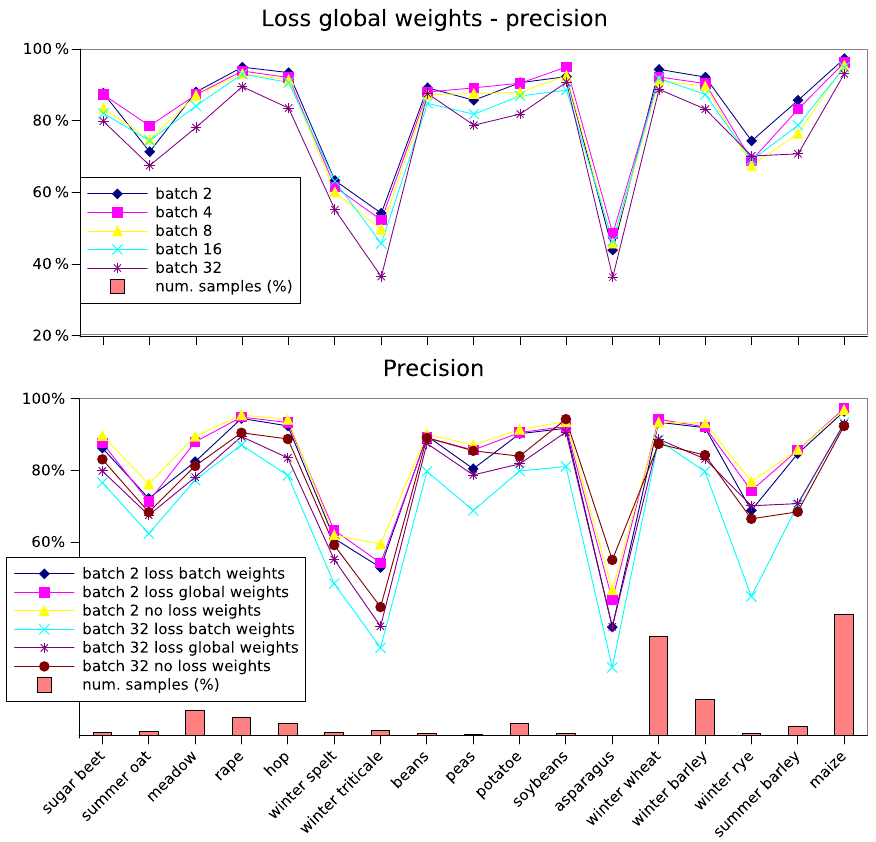
Figure 7. Precision of the FPN 3D model as the batch size varies on the dataset Munich. The plot on the top shows how the precision for each class changes as the batch size in the training phase changes when the loss function weights are calculated for each batch. The plot on the bottom compares three different loss function weighting techniques when the batch size is 2 and 32.